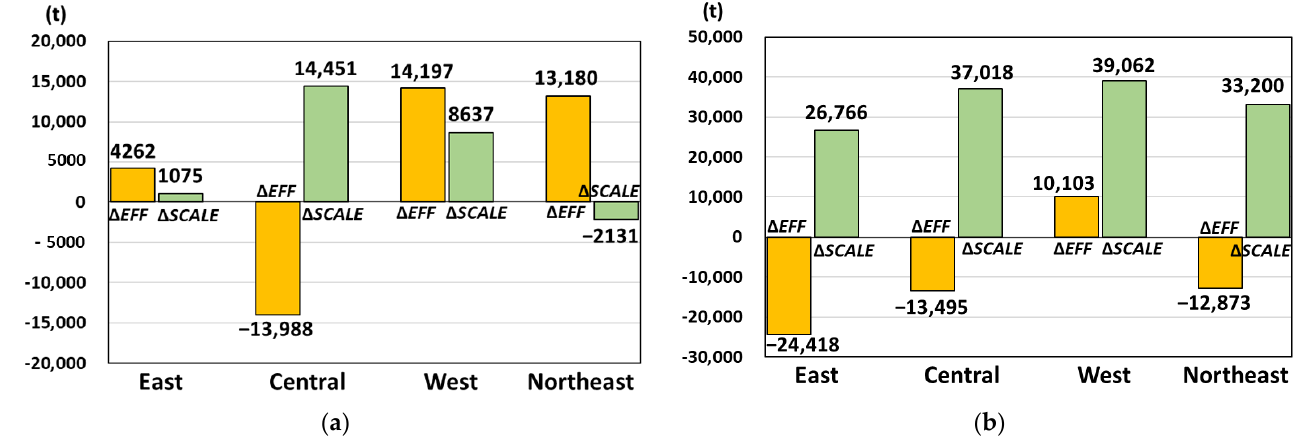
Figure 7. Comparison between average efficiency and scale change effects in ( a ) the SM group and ( b ) the LARGE group across the four regions. ( b ) the LARGE group across the four